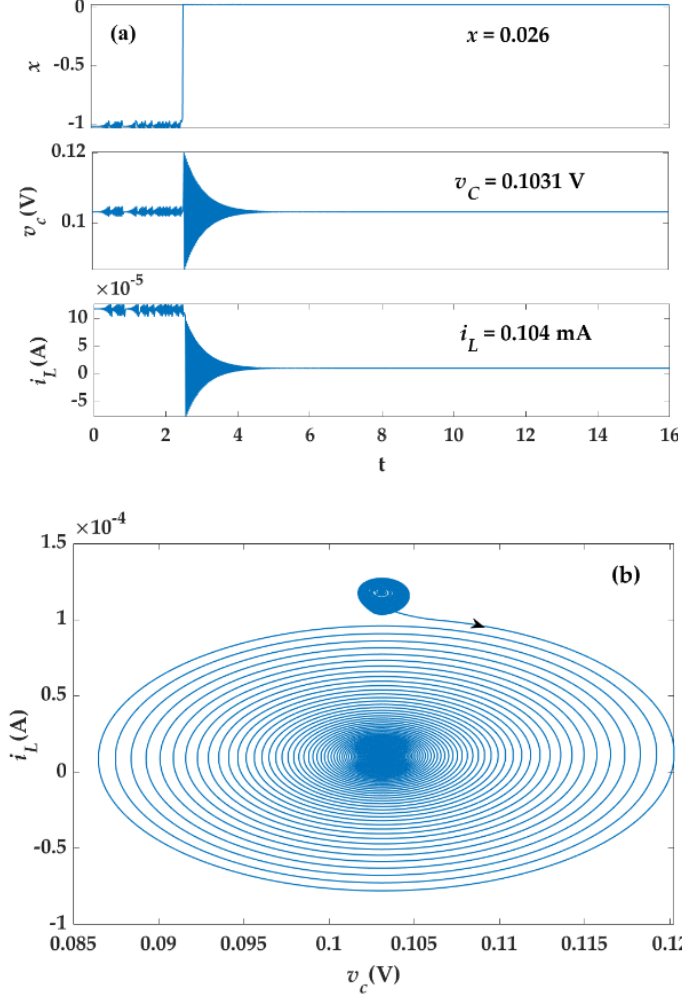
Figure 20. Variation in system attractor ( a ) waveforms and ( b ) v c - i phase with C = 26.2 μ F.